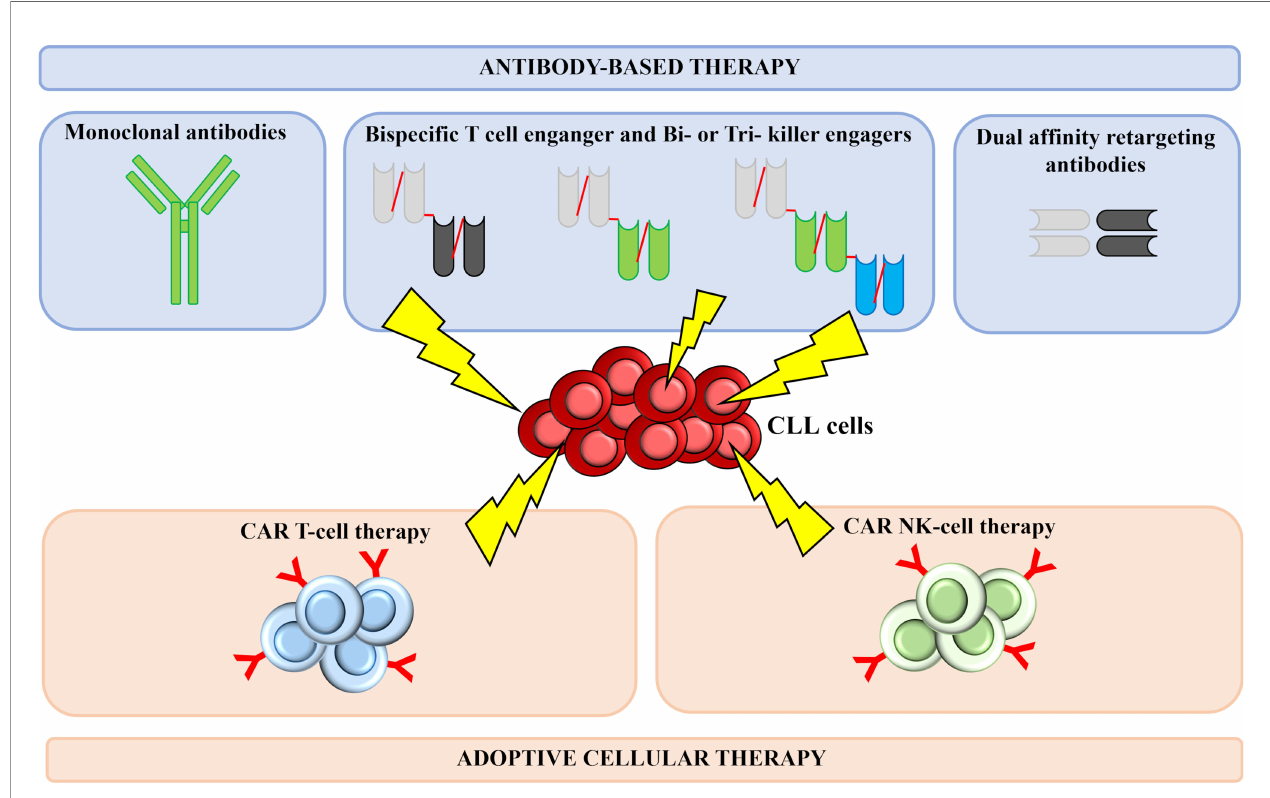
FIGURE 2 | Successful immunotherapeutic strategies implemented in CLL. Several immune-based therapeutic strategies are under development for CLL treatment. Thanks to their successful results, antibody-based therapies and adoptive cellular therapies currently represent the main fi eld of investigation in the context of CLL. Monoclonal antibodies act by binding a speci fi c antigen expressed on the surface of leukemia cells, thus generating cytotoxic responses. Bispeci fi c T cell-engagers are small antibody-based molecules that contain two antigen-binding domains capable of redirecting T cells against antigen-bearing cancer cells. Bi- and tri-speci fi c killer cell engagers consist of two or three antigen-recognition domains and are capable to simultaneously target a tumor cell antigen and a molecule expressed on the surface of NK cells, with the aim of triggering immune cells against tumor cells. DART are designed in a criss-cross format in order to improve pharmacokinetic pro fi le and T-cell killing. CAR T and CAR NK cells are T lymphocytes and NK cells engineered to express a chimeric receptor, able to recognize a tumor surface antigen; upon antigen recognition and activation of the costimulatory domains, a cytotoxic response is activated, leading to leukemia cells killing. CLL, chronic Lymphocytic Leukemia; CAR, Chimeric Antigen Receptor; NK, Natural